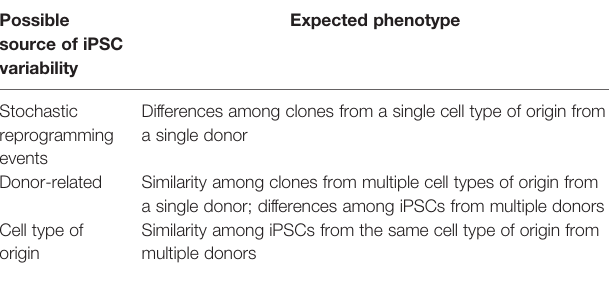
TABLE 1 | Possible sources of iPSC